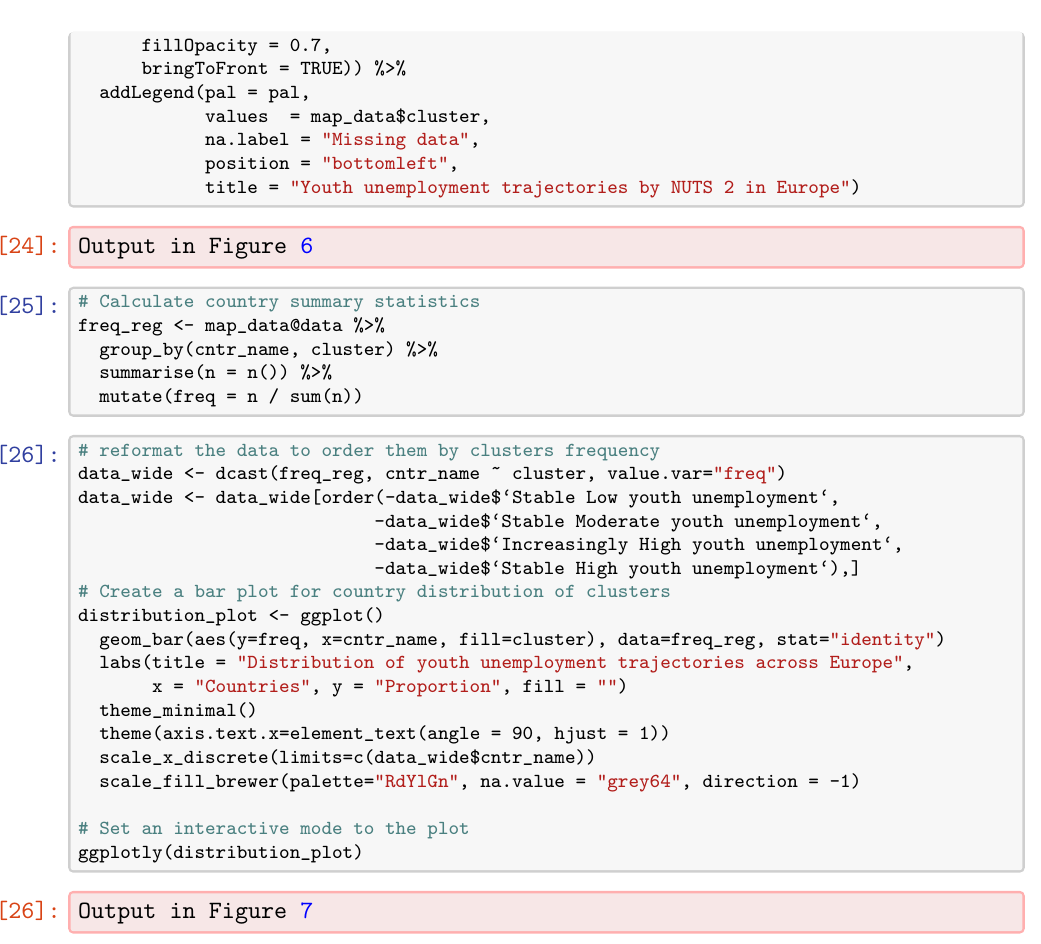
Figure 7: Distribution of youth unemployment trajectories across Europe from 2008 to